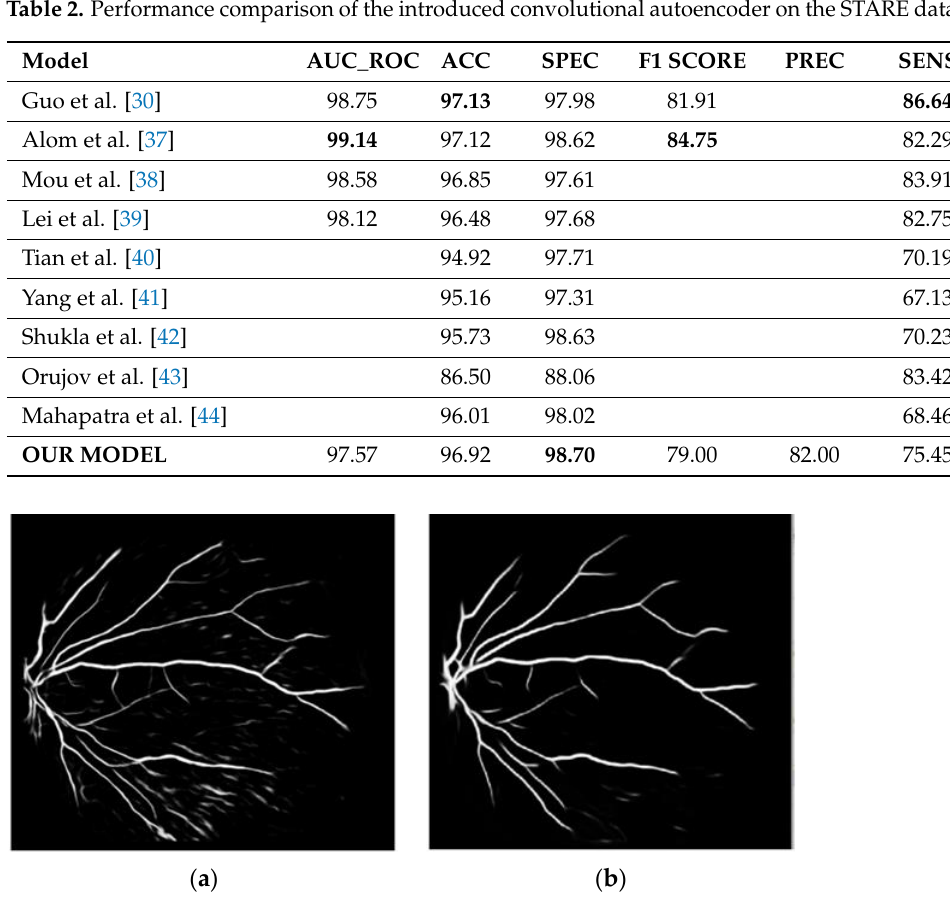
Figure 8. Comparison against existing method. ( a ) An attempt of automatic segmentation by the Octave Convolution Neural Network [45]. ( b ) The corresponding automated vessel segmentation of our proposed convolutional autoencoder.